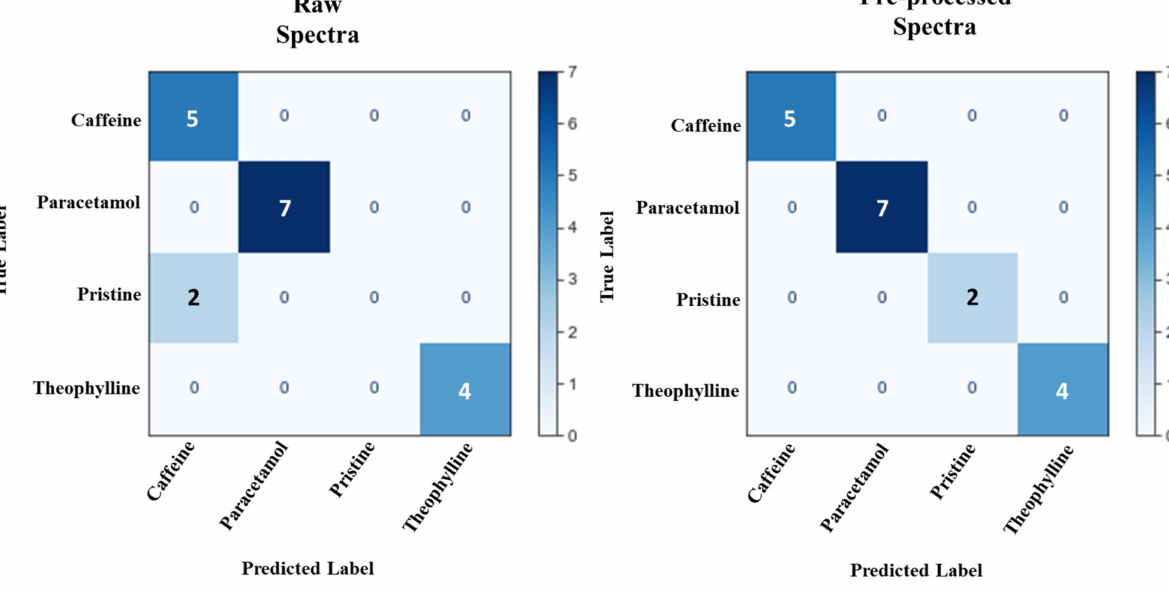
Figure 11. Confusion matrix depicting the results of the LDA prediction for both the raw and pre-processed NIR